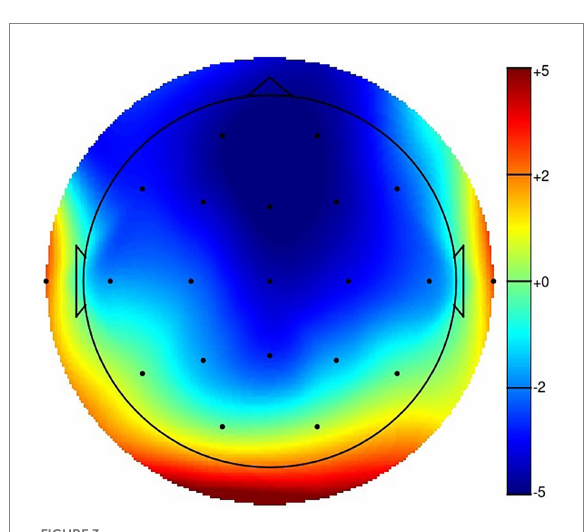
FIGURE 3 Topographical map of the N200. NoGo - Go, 218 ms.